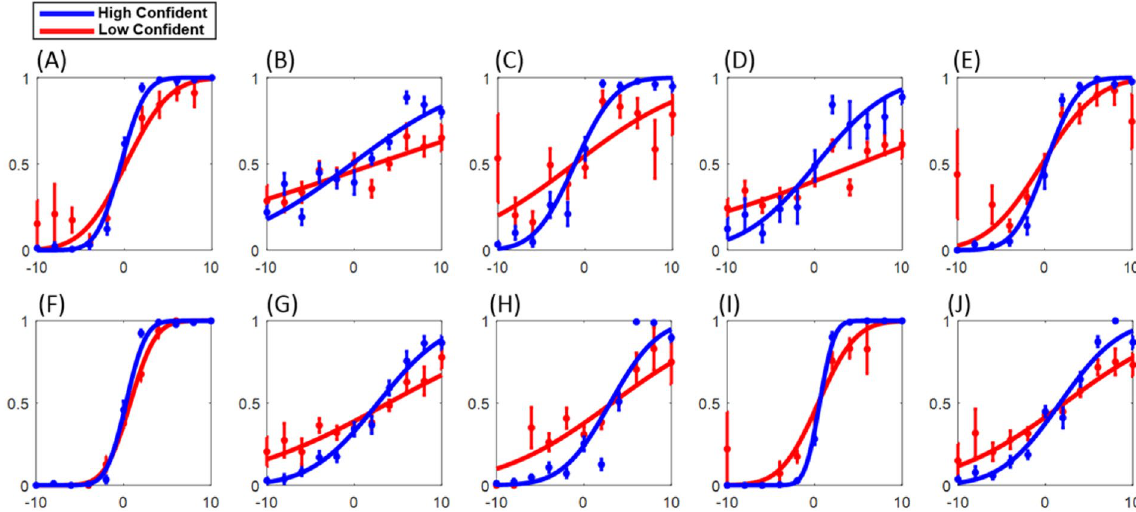
Figure 6. The Performance of overall subjects in high confidence and low confidence groups: ( A )- Unimodal, high reliability visual. ( B )- Unimodal, low reliability visual. ( C )- Unimodal, high reliability tactile. ( D )- Unimodal, low reliability tactile. ( E )- Unimodal, medium reliability auditory. ( F )- Multimodal high reliability visual-medium reliability auditory. ( G )- Multimodal, low reliability visual-medium reliability auditory. ( H )- Multimodal, high reliability tactile-low reliability visual-medium reliability auditory. ( I )- Multimodal, low reliability tactile-high reliability visual-medium reliability auditory. ( J )- Multimodal, low reliability tactile-low reliability visual-medium reliability auditory. The error bars show the standard deviation for running the bootstrap with 1000